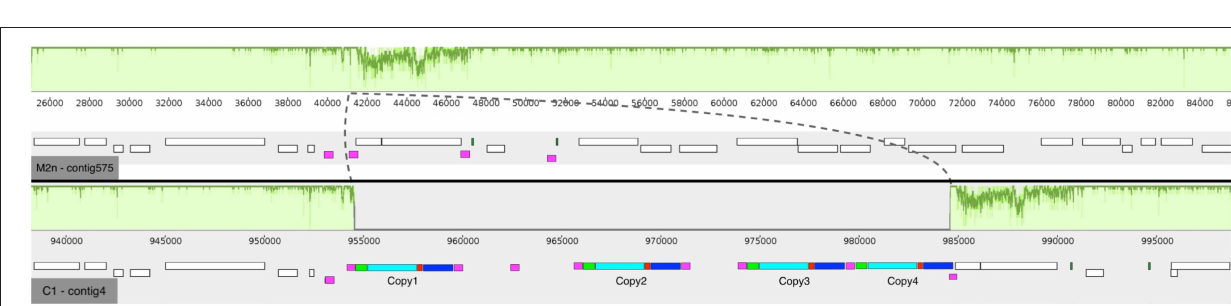
FIGURE 2 | Mauve multi-alignment of the sequences of Chromosome XV of the parental S. cerevisiae M2n (contig 575) and the engineered strain C1 (contig 4). The green plots above each sequence show the identity between the two strains. The dashed lines show the inserted region in respect to the M2n parental strain. The white boxes beneath each sequence indicate the annotated genes and the purple ones show the δ -elements of Ty retrotransposon. In the case of the recombinant S. cerevisiae C1, the colored boxes show the inserted cassette where green are the promoter sequences, cyan the BGL3 gene, red the terminator sequences and blue the kanamycin resistance